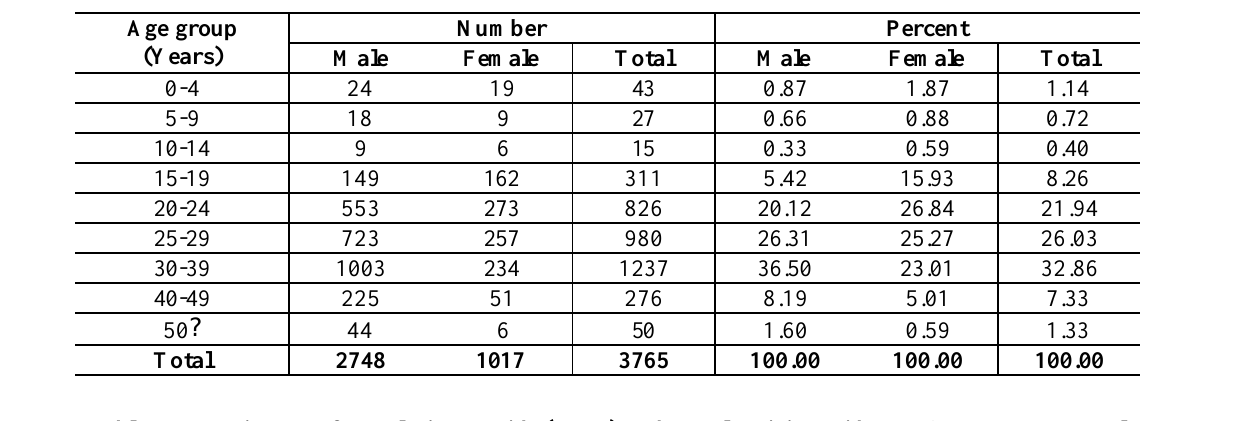
Table III : Cumulative HIV infection by age group as of May 2004